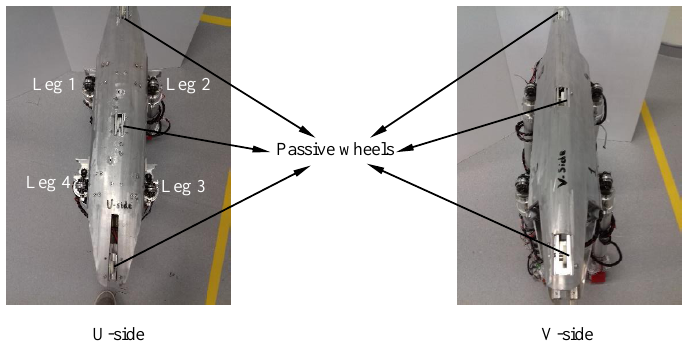
Figure 3. Two manually reconfigurable states and rotating the legs by 180 degrees which turns the body upside